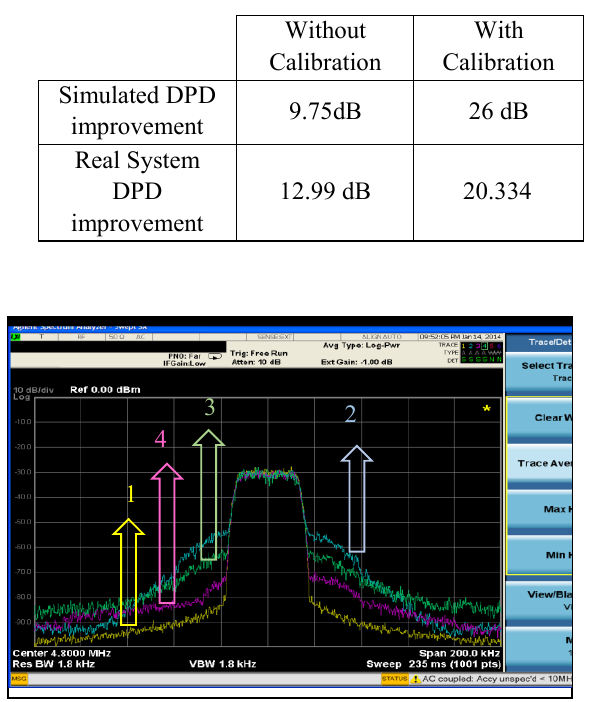
Fig. 12 VSA screen showing frequency spectrum of input(yellow-1), output(blue-2) and un-calibrated DPD output(green-3) and calibrated DPD